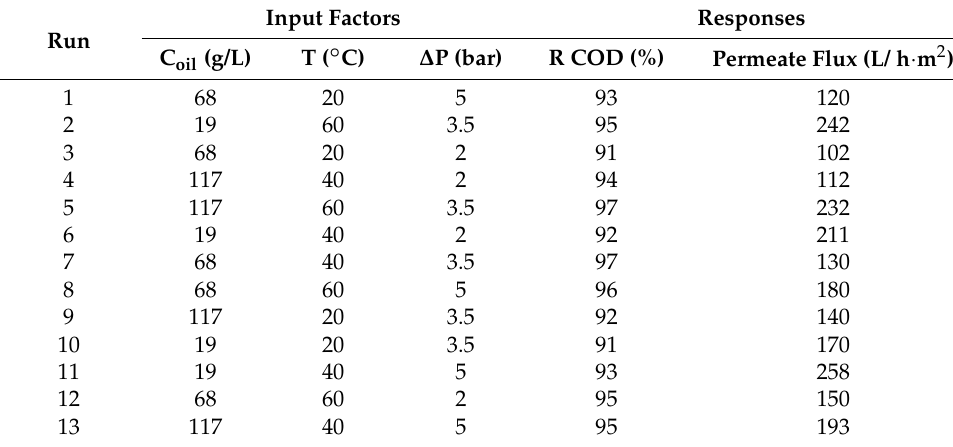
Table 3. Box–Behnken experimental design and